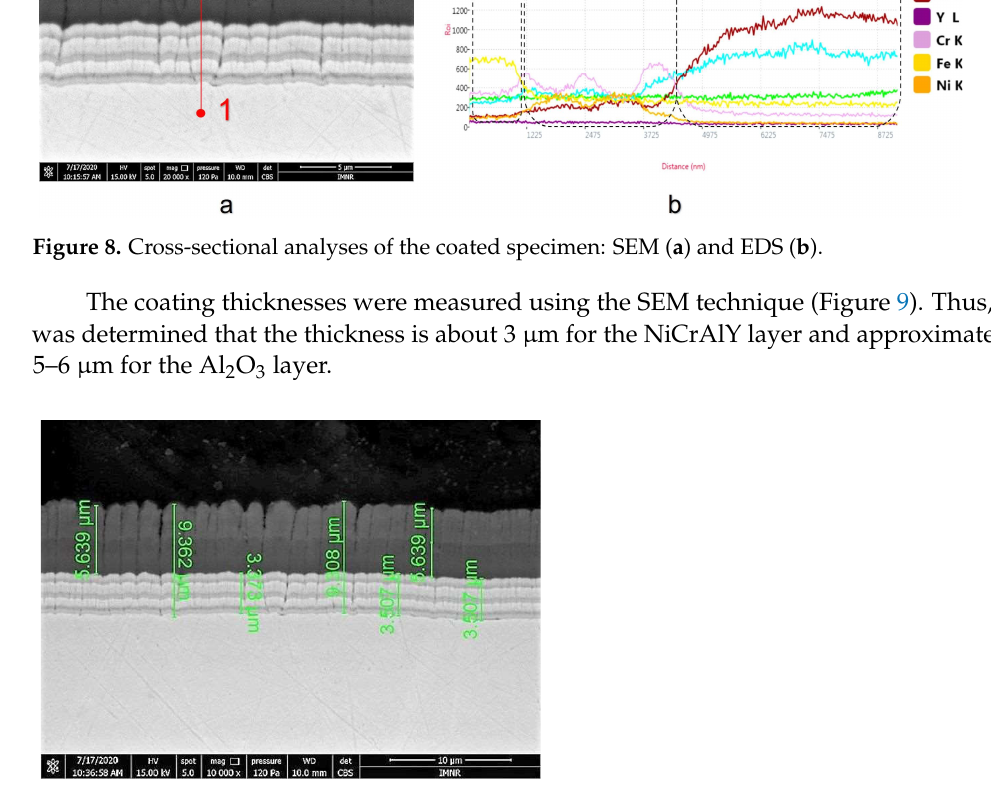
Figure 9. SEM images of the layer thicknesses before the corrosion tests.